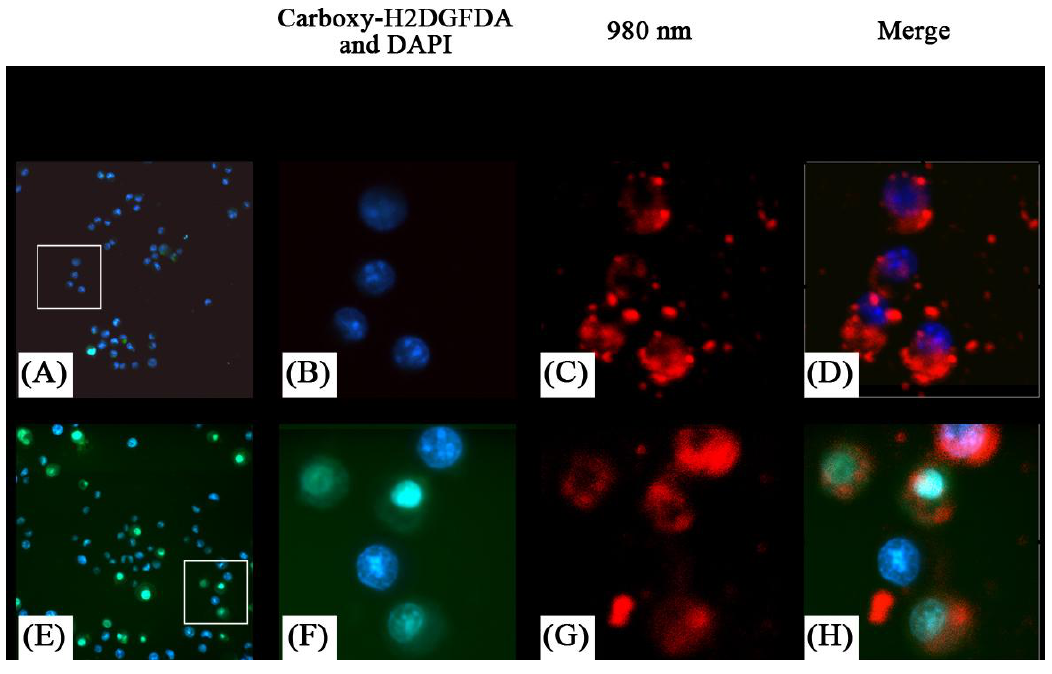
Figure 20. Detection of oxidative stress in live cells using MB49-PSA cells treated with NaYF nanoparticles ( A – D ) or ZnPc-loaded NaYF nanoparticles ( E – H ) followed by laser 4 4 activation to induce oxidative stress. Insets in ( A ) and ( E ) show the region that has been enlarged in ( B – D ) and ( F – H ) respectively. Presence of reduced oxygen species are shown in green, (green) nuclei in blue, and the nanoparticles are shown by their red fluorescence color ([76], reproduced by permission of